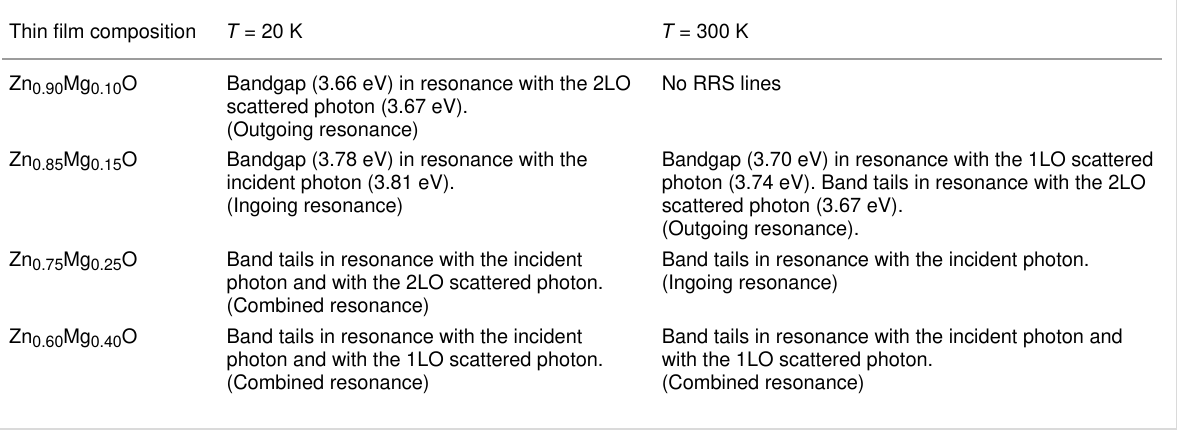
Table 4: The conditions of resonance Raman scattering in ZnMgO films for various compositions and temperatures. Thin film composition T = 20 K T = 300 K Zn 0.90 Mg 0.10